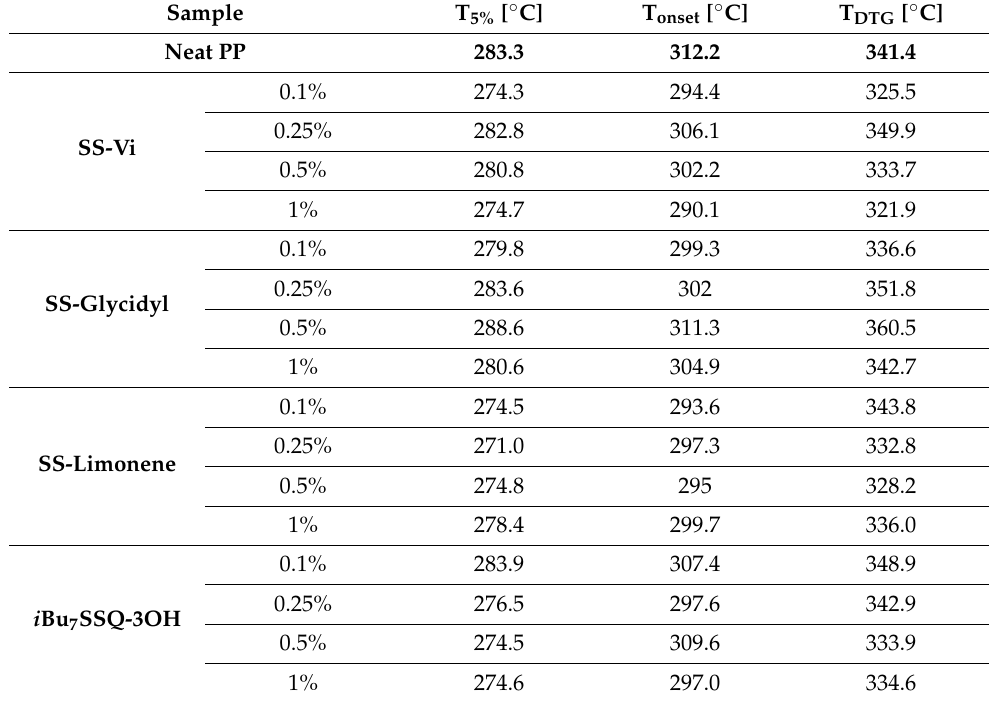
Table 3. Results of thermogravimetric analysis (air